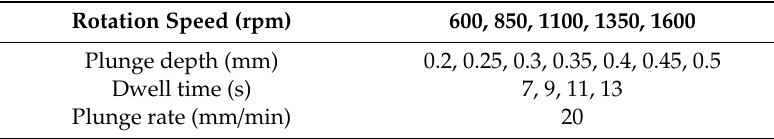
Figure 1. Configuration of probeless tools: ( a ) archimedes tool, ( b ) involute tool, and ( c ) concave tool. Table 2. Parameters for P-FSSW.